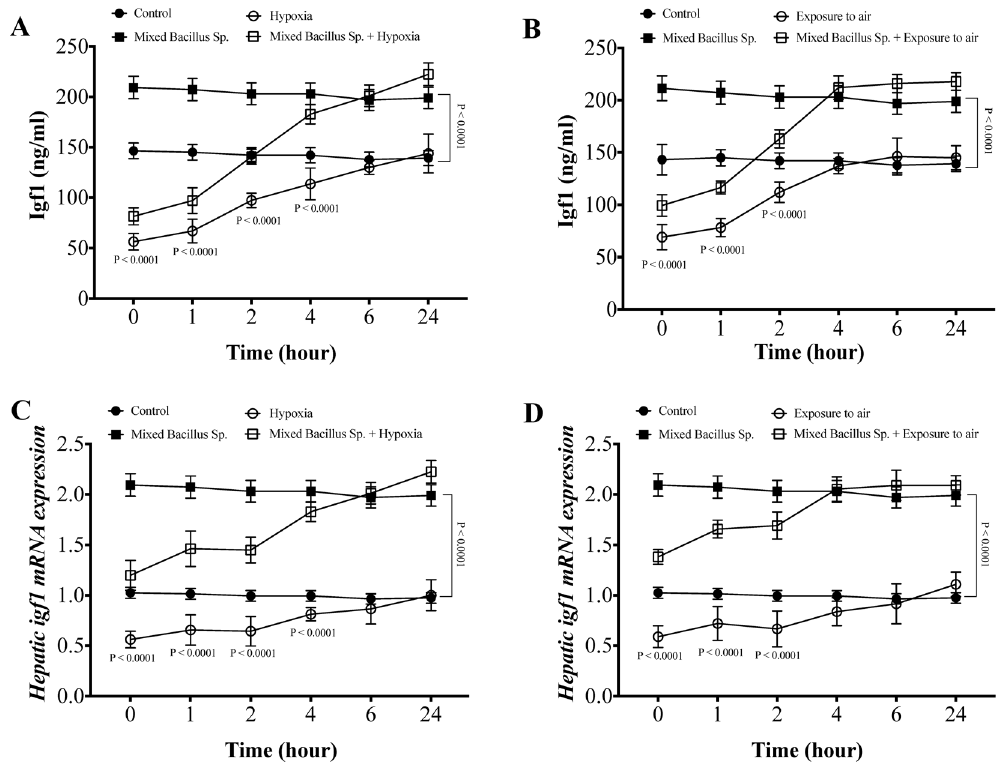
Figure 4. A mixed Bacillus Species promotes the expression of insulin like growth factor (Igf1). Yellow Perch response to hypoxia and air exposure stress over 24 h as reflected in ( A , B ) plasma Igf1 levels and hepatic igf1 mRNA expression that were quantified using ELISA and RT-qPCR. Sample size = 9/group. Two-way